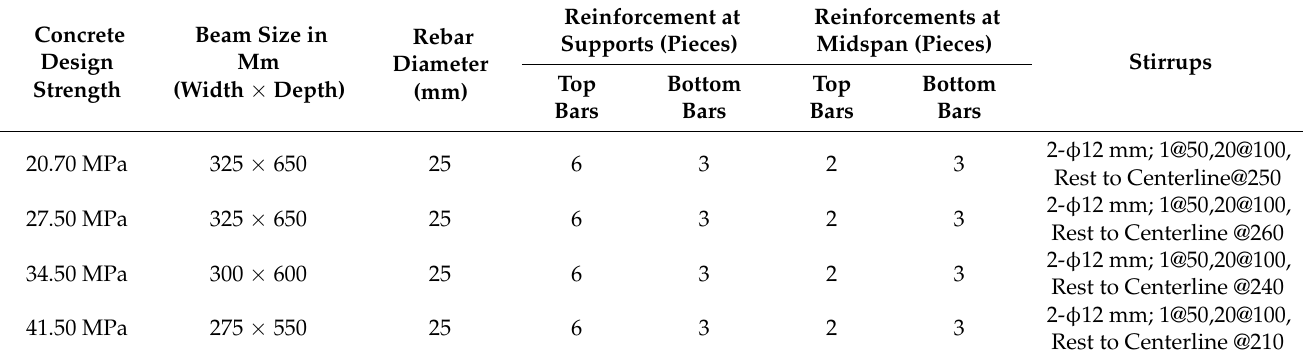
Table 6. Three-story building beam sizes and reinforcements.